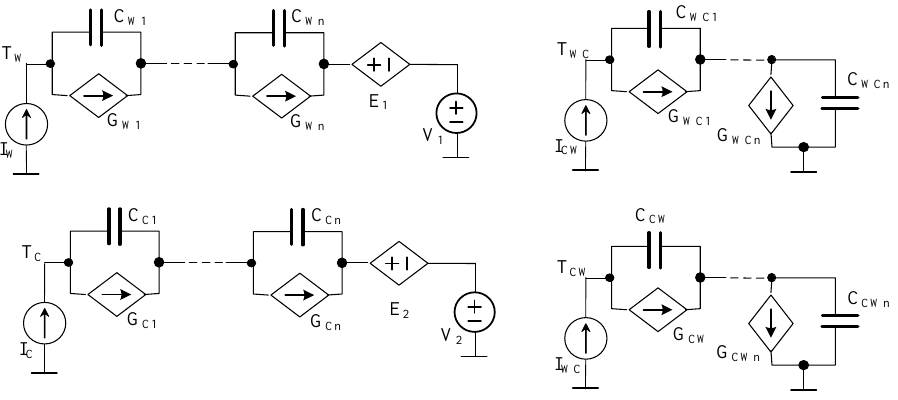
Figure 1. Nonlinear compact thermal model of the inductor.